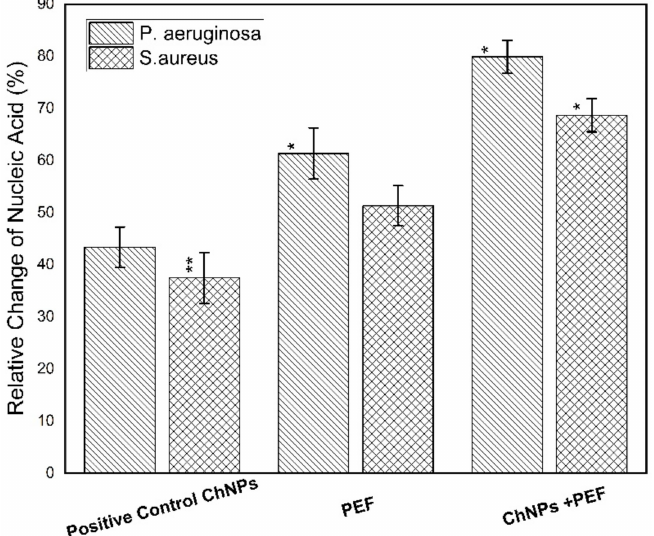
Figure 11. Relative change of nucleic acid percentage for P. aeruginosa and S. aureus samples treated by ChNPs and PEF each alone and combined with exposure to PEF. * statistically significant, ** statis- tically highly